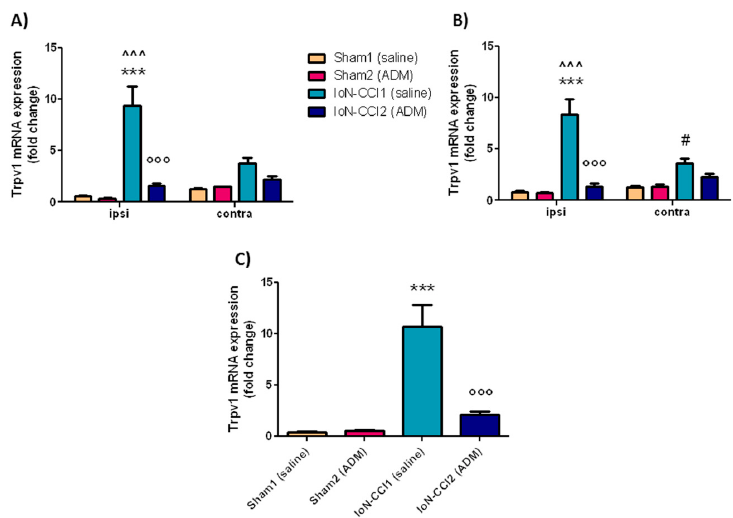
Figure 3. Trpv1 mRNA expression in TGs ( A ), CSC ( B ), and medulla ( C ). Data is expressed as mean + SEM. One way analysis of variance (ANOVA) followed by Tukey’s Multiple Comparison Test or Two-way ANOVA followed by Bonferroni post-hoc test, *** p < 0.001 vs. Sham1 and Sham 2 (ipsi), °°° p < 0.001 vs. IoN-CCI1 (ipsi), ^^^ p < 0.001 vs. IoN-CCI1 (contra), # p < 0.05 vs. Sham1 and Sham2 (contra).